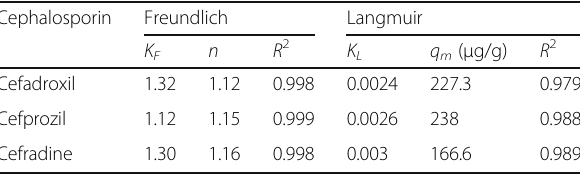
Table 7 Isotherm parameters obtained by fitting equilibrium data with Langmuir and Freundlich isotherms for cephalosporins adsorption on MSN